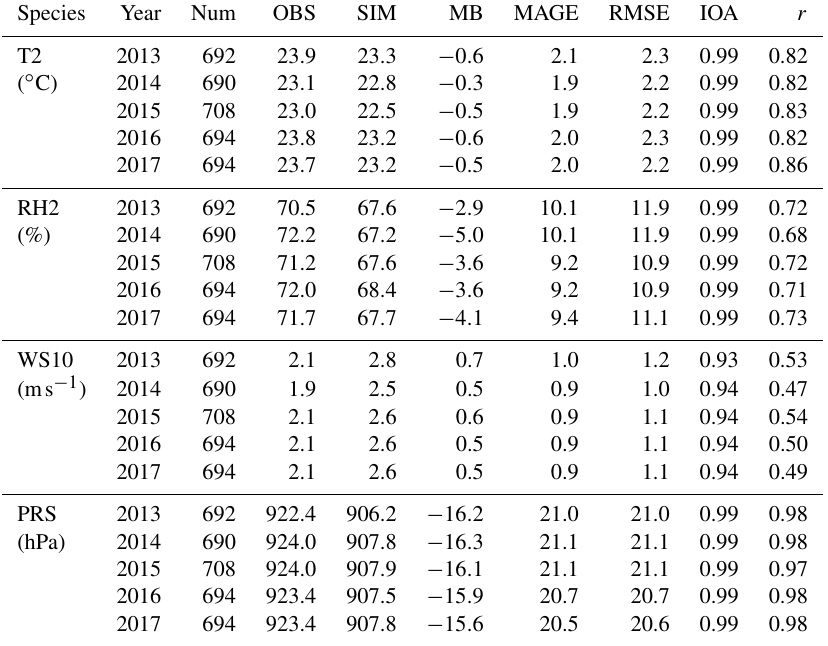
Table 1. Evaluation results for the meteorological factors (T2 is temperature at a height of 2m; RH2 is relative humidity at a height of 2m; WS10 is wind speed at a height of 10m; PRS is surface pressure; Num is number of sites with available observation for statistics; OBS is mean observation; SIM is mean simulation; MB is mean bias; MAGE is mean absolute gross error; RMSE is root mean square error; IOA is index of agreement; r is correlation coefficient; OBS, SIM, MB, MAGE, and RMSE have the same units as given in the first column, while IOA and r have no